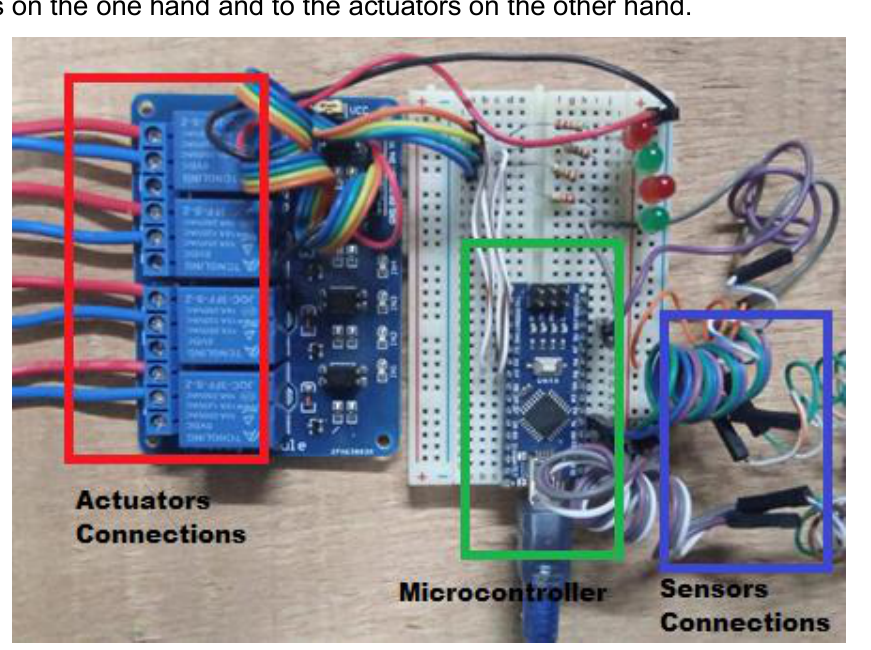
Figure 4 . Sensor / Actuator Device